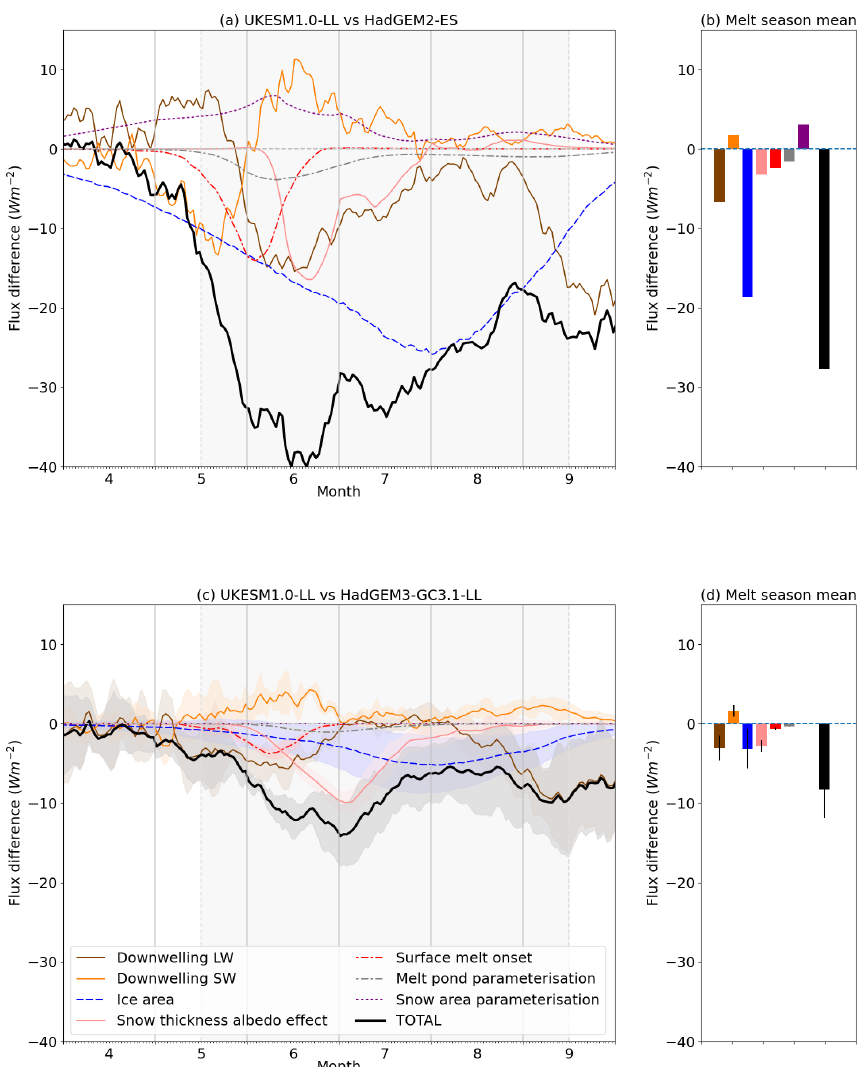
Figure 6. Illustration of drivers of summer melting differences, using the ISF framework. Shown are ISF differences between (a, b) UKESM1.0-LL and HadGEM2-ES and (c, d) UKESM1.0-LL and HadGEM3-GC3.1-LL, apportioned by downwelling SW, ice area, snow thickness, surface melt onset, direct impact of snow fraction parameterisation and direct impact of the UKESM1.0 melt pond scheme. Showing April–September daily evolution (left column) and melt season mean (right column, 16 May–15 September). For the first compari- son, only the first ensemble member is shown, as daily data are not available for other members of HadGEM2-ES; for the second comparison, all four ensemble members of both models are used, with ensemble mean and standard deviation